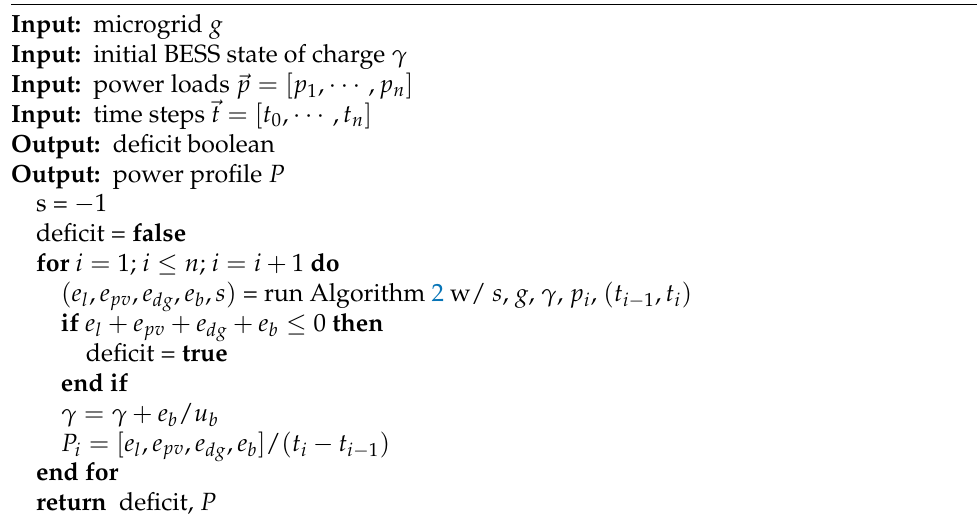
Algorithm 3 Simulated microgrid